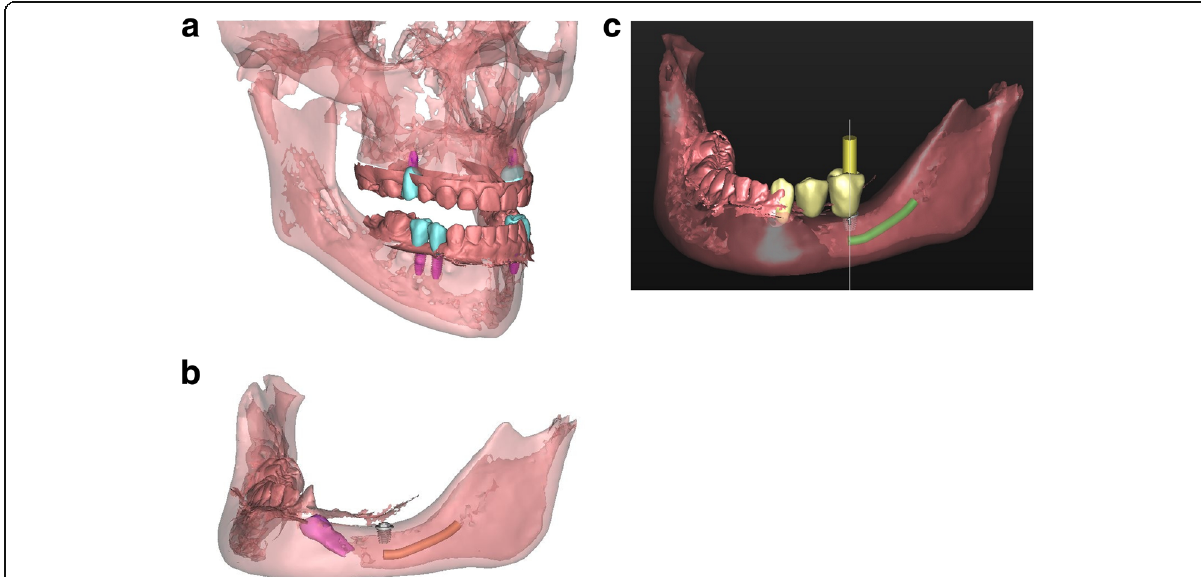
Fig. 4 a Patient 1 — virtual set-up of the ultimate treatment goal. b Patient 2 — virtual set-up of the ultimate implant position. One short dental implant was planned in region 35, based on the location of the mandibular nerve ( orange ), the impacted 34 ( pink ) and the bone quality and volume. c Patient 2 — virtual set-up of the ultimate prosthetic treatment goal